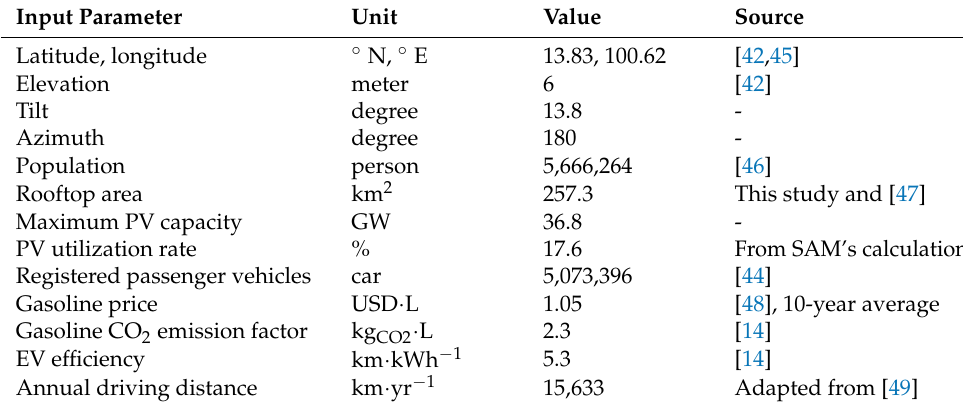
Table 1. Input parameters for the analyses of Bangkok